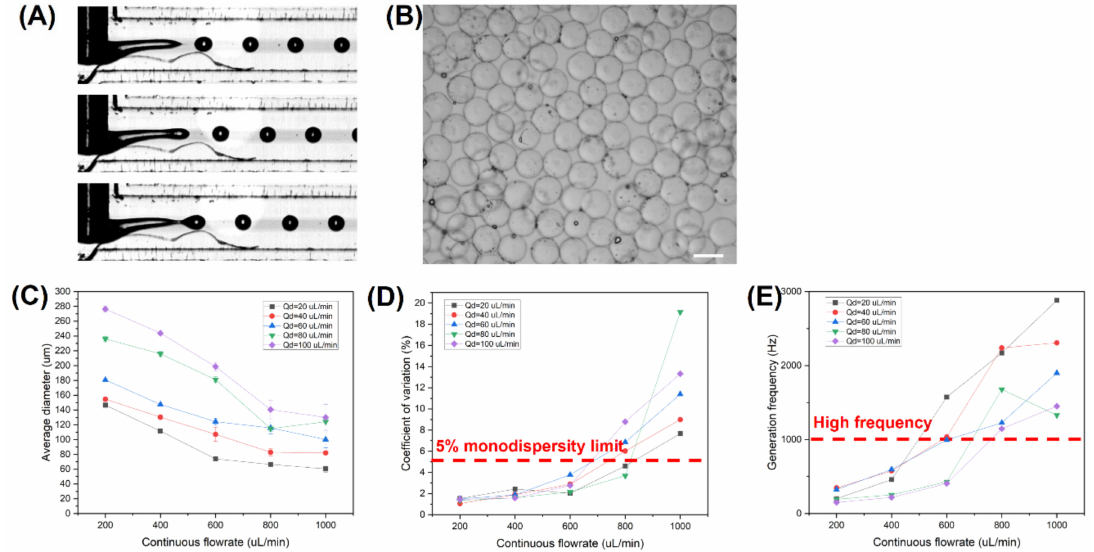
Figure 5. Microfluidic-based fabrication of alginate–gelatin microspheres: ( A ) generation of monodis- perse alginate–gelatin microspheres at high-throughput stable narrowing jetting regime; ( B ) mi- croscopic images of typical alginate–gelatin microspheres generated by the designed microfluidic system, wherein the scale bar is 150 µ m; ( C ) average microdroplet diameters at different flowrate conditions with dispersed liquid of 1% alginate +7.5% gelatin and continuous phase of soybean oil +8% PGPR; ( D ) CV of microdroplets generated at different flowrate conditions; ( E ) microdroplet generation frequency at different flowrate